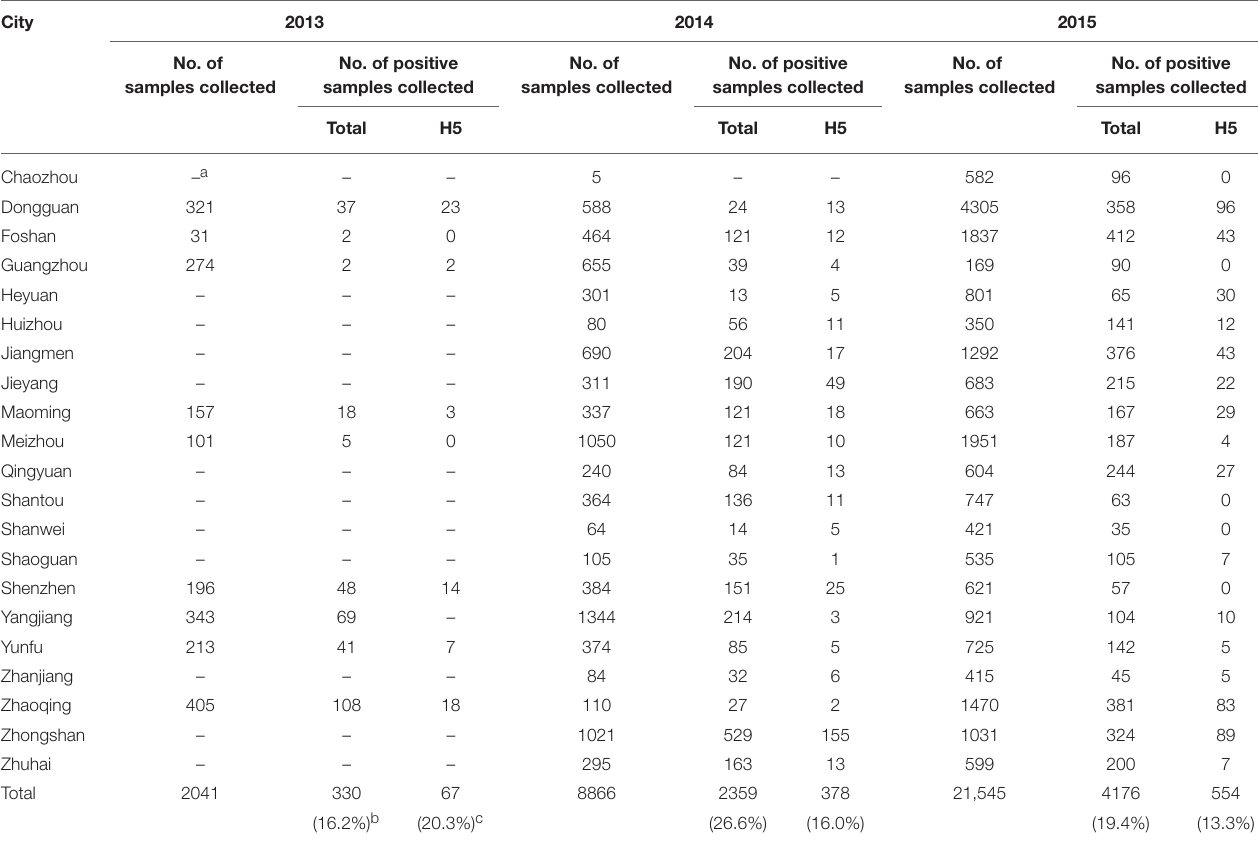
TABLE 2 | Environment surveillance of H5-subtype avian influenza viruses in Guangdong, 2013–2015. City 2013 No. of No. of positive No. of No. of positive No. of samples collected samples collected samples collected samples collected samples